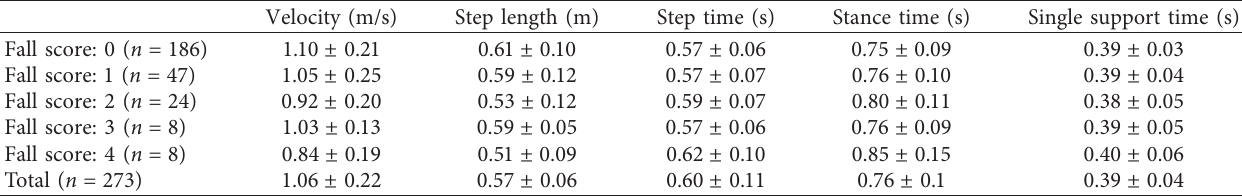
Table 3: Mean and standard deviations of spatiotemporal parameters across fall frequency